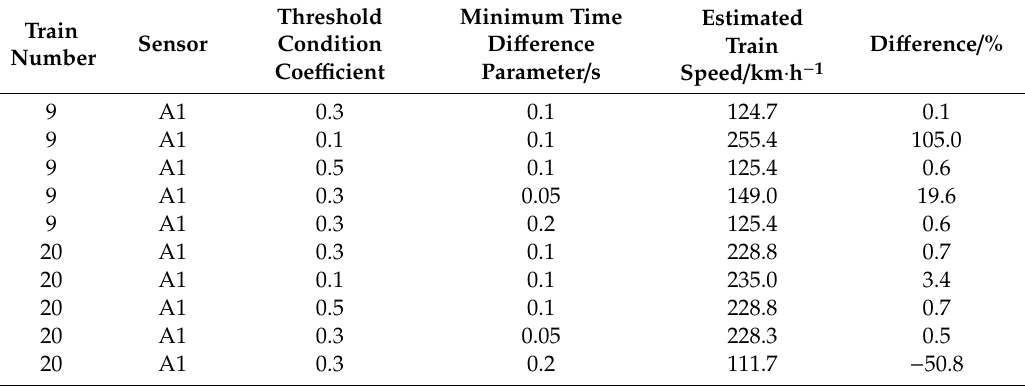
Table 4. The results of automatic train speed estimation with di ff erent